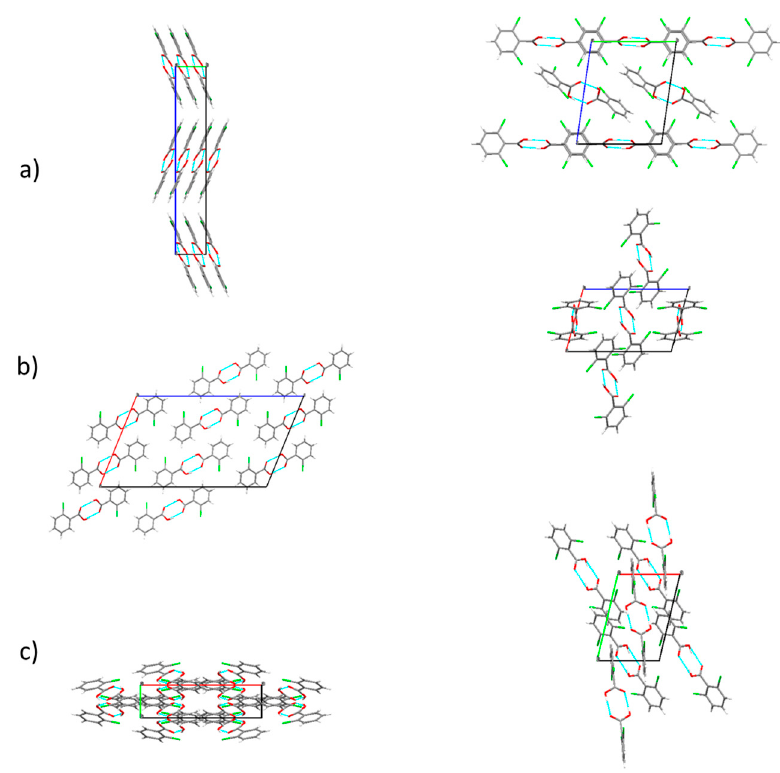
Figure 19. Crystal packing for 26DFBA ( left ) and 2C6FBA ( righ t) as viewed from the a ( top ), b ( middle ) and c ( bottom ) crystallographic axes. Data from [22], and [24], respectively.